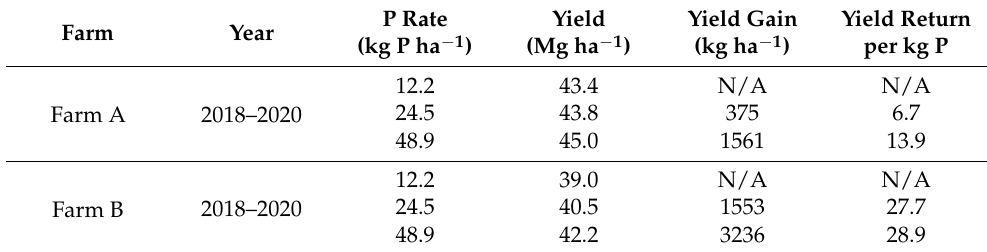
Table 13. Potato yield gain and return in Farms A and B.